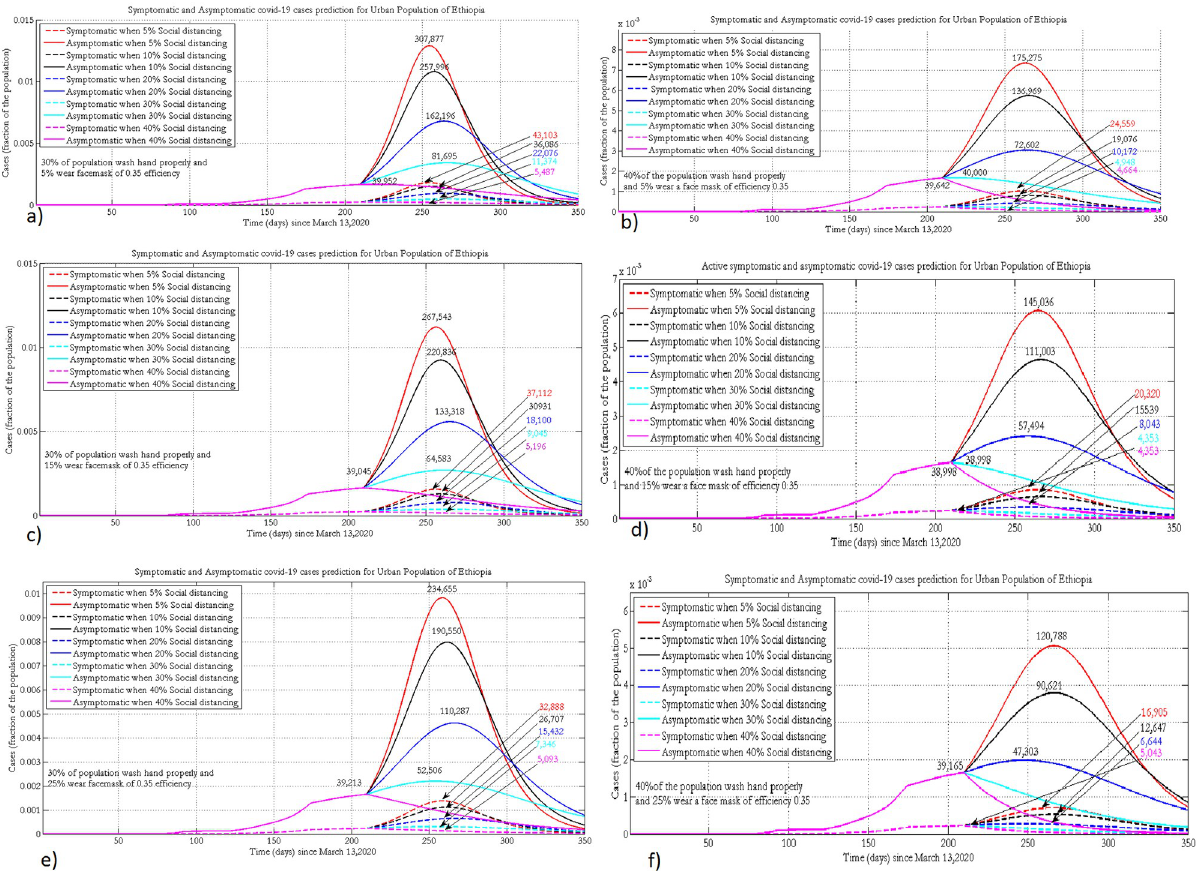
Fig 4. Projection of symptomatic and asymptomatic infectious cases in urban populations of Ethiopia when 30% or 40% practice hand washing and 5% (a, b), 15% (c, d) or 25% (e, f) of the population wear face masks, with 35% efficacy.